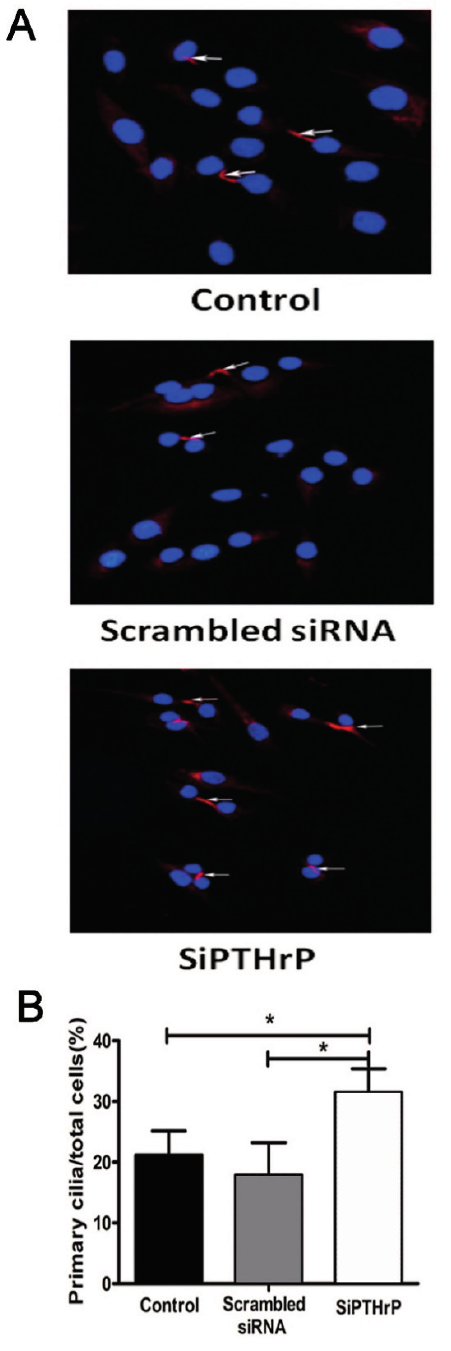
Figure 6. PTHrP silence could increase primary cilia expression. ( A ) Using siRNA to silence PTHrP gene expression caused elevated ciliogenesis, compared with the empty control ( p = 0.003) and negative ( p = 0.000) groups; ( B ) The relative percentage of primary cilia in different treatment groups is shown. Three independent experiments were conducted. The white arrows refer to primary cilia. ( * p <